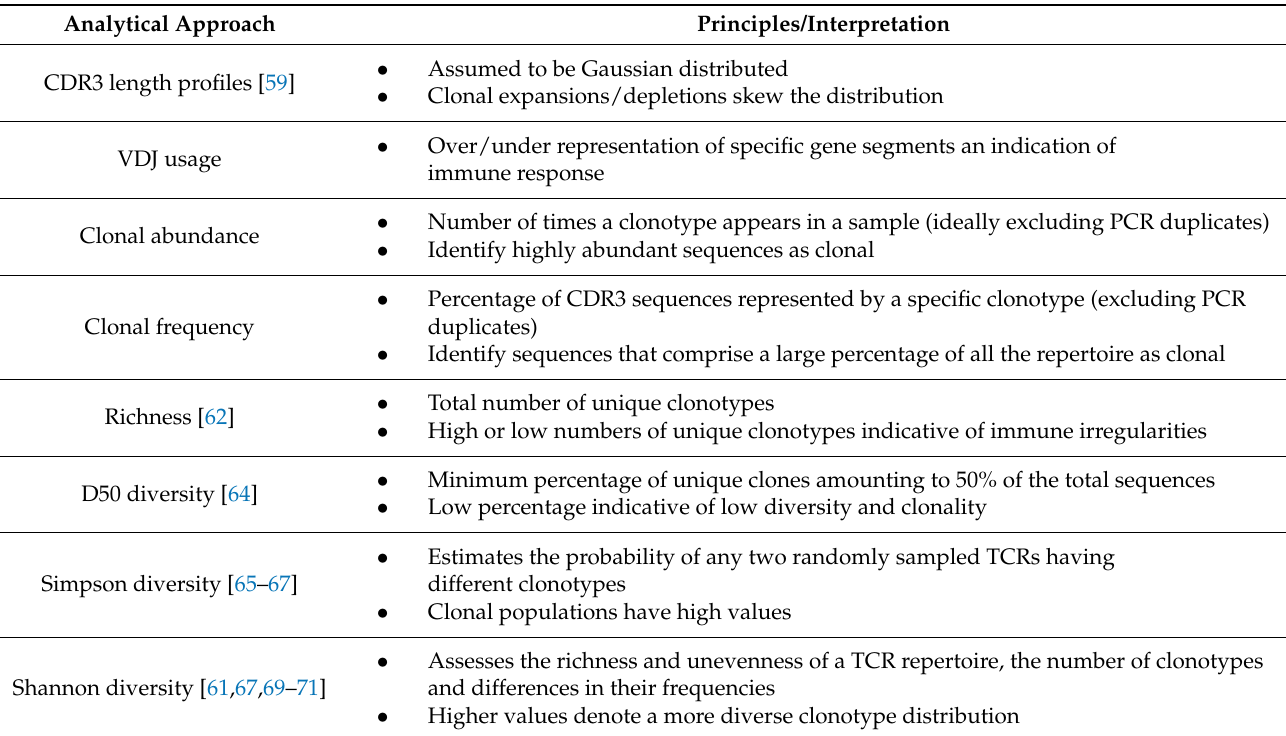
Table 2. Diversity-based methods of TCR repertoire